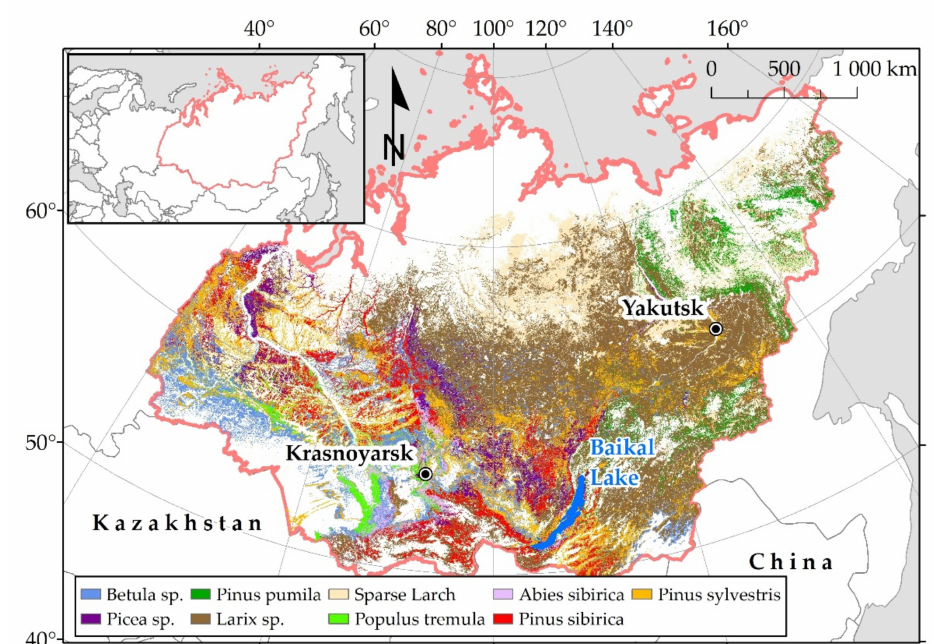
Figure 1. Territory of Siberia. Main Siberian forest types (based on http://pro-vega.ru/maps/, accessed on 25 March 2021) [21]. Forest types range from “sparse” (crown closure <20%) to “closed” (>80% crown closure) tree stands.